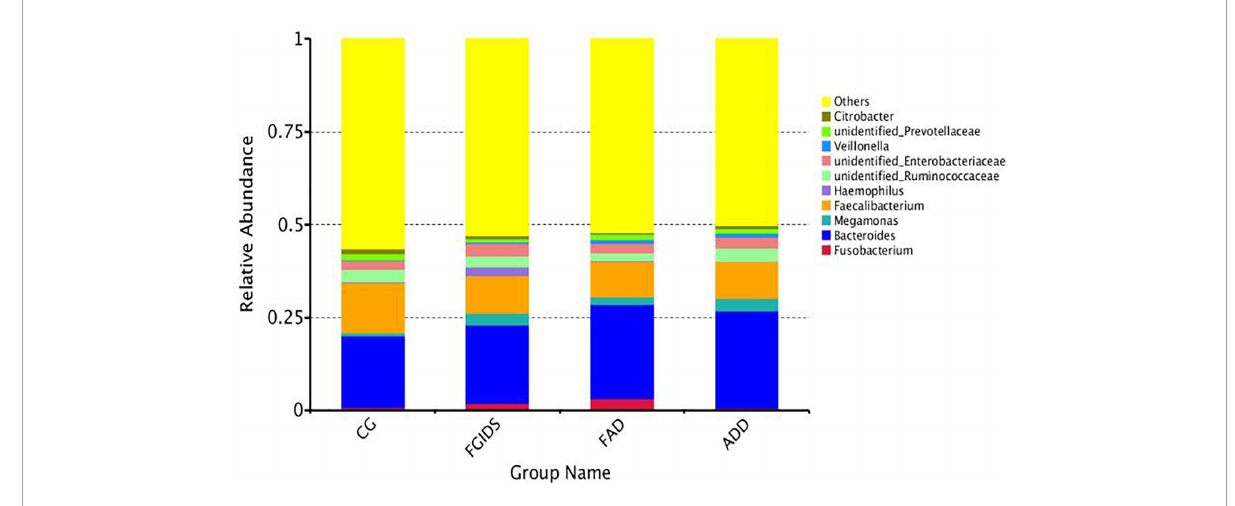
FIGURE4 Stack diagram of horizontal species distribution of